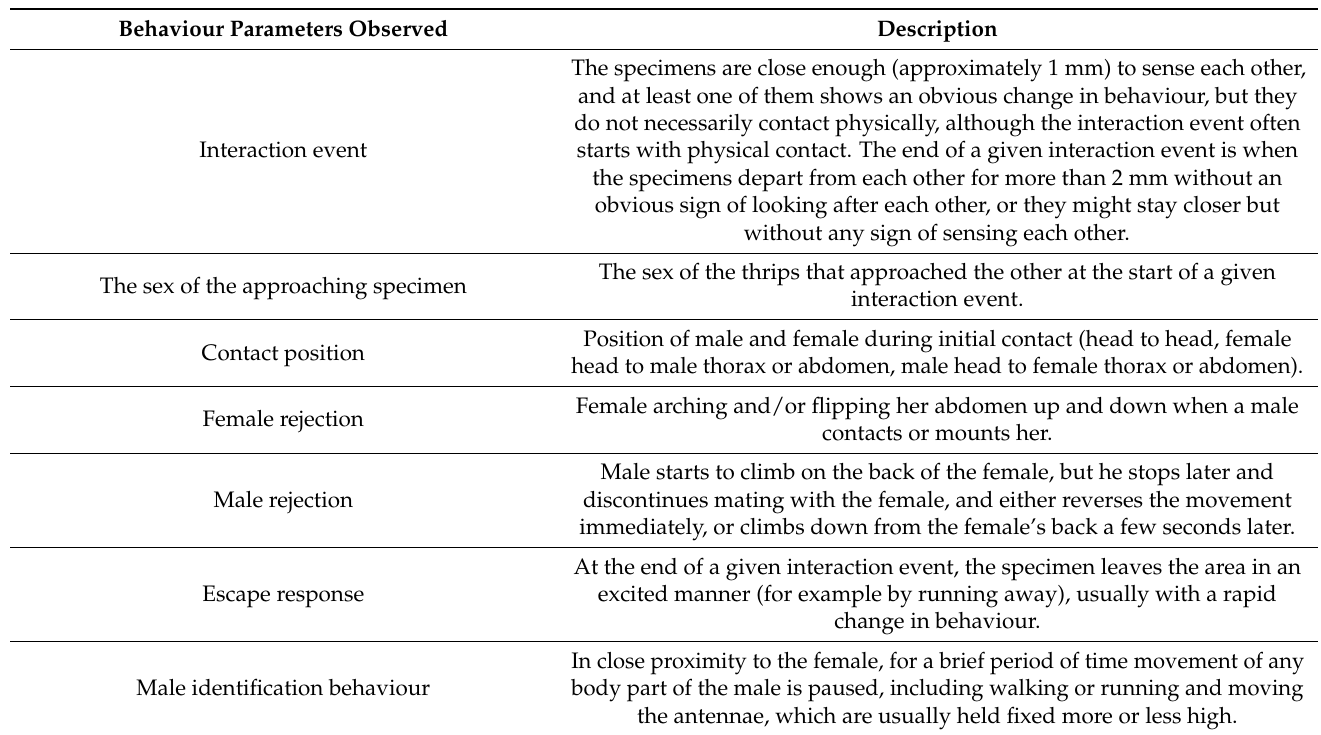
Table 2. List and description of monitored behaviour parameters during interactions of male and female